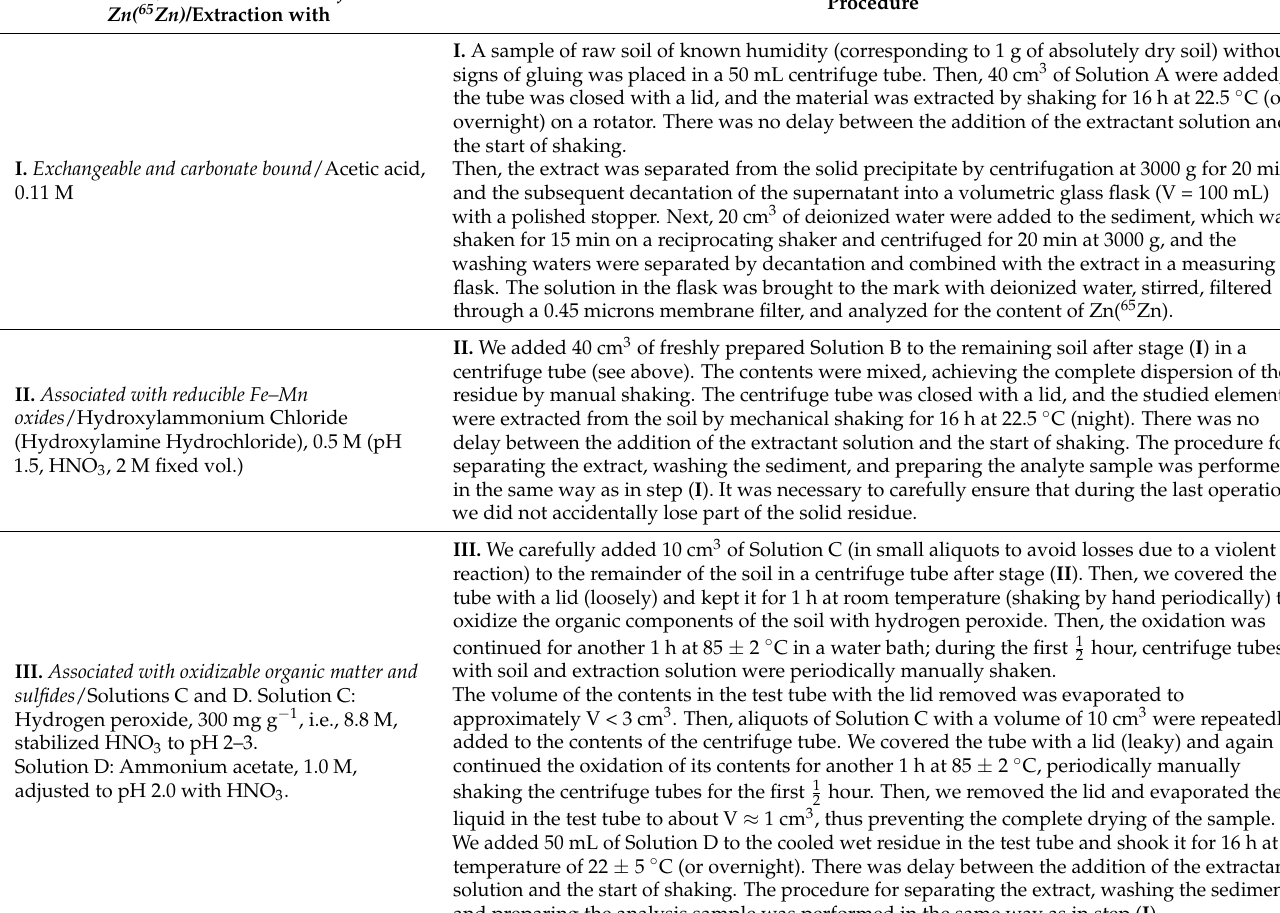
Table 3. Sequental Extraction Procedure by BCR modified method